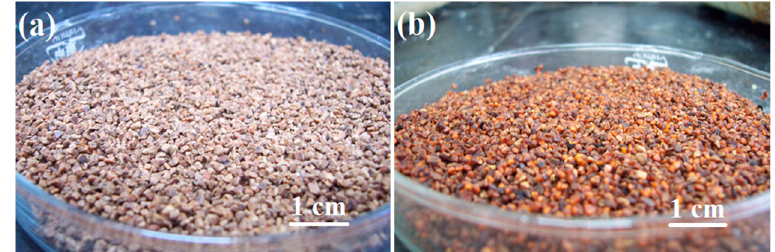
Figure 7. Nutshell ( a ) and coated nutshell ( b ) proppant. Table 6. Properties of polymer coated bio-based nutshell proppant.